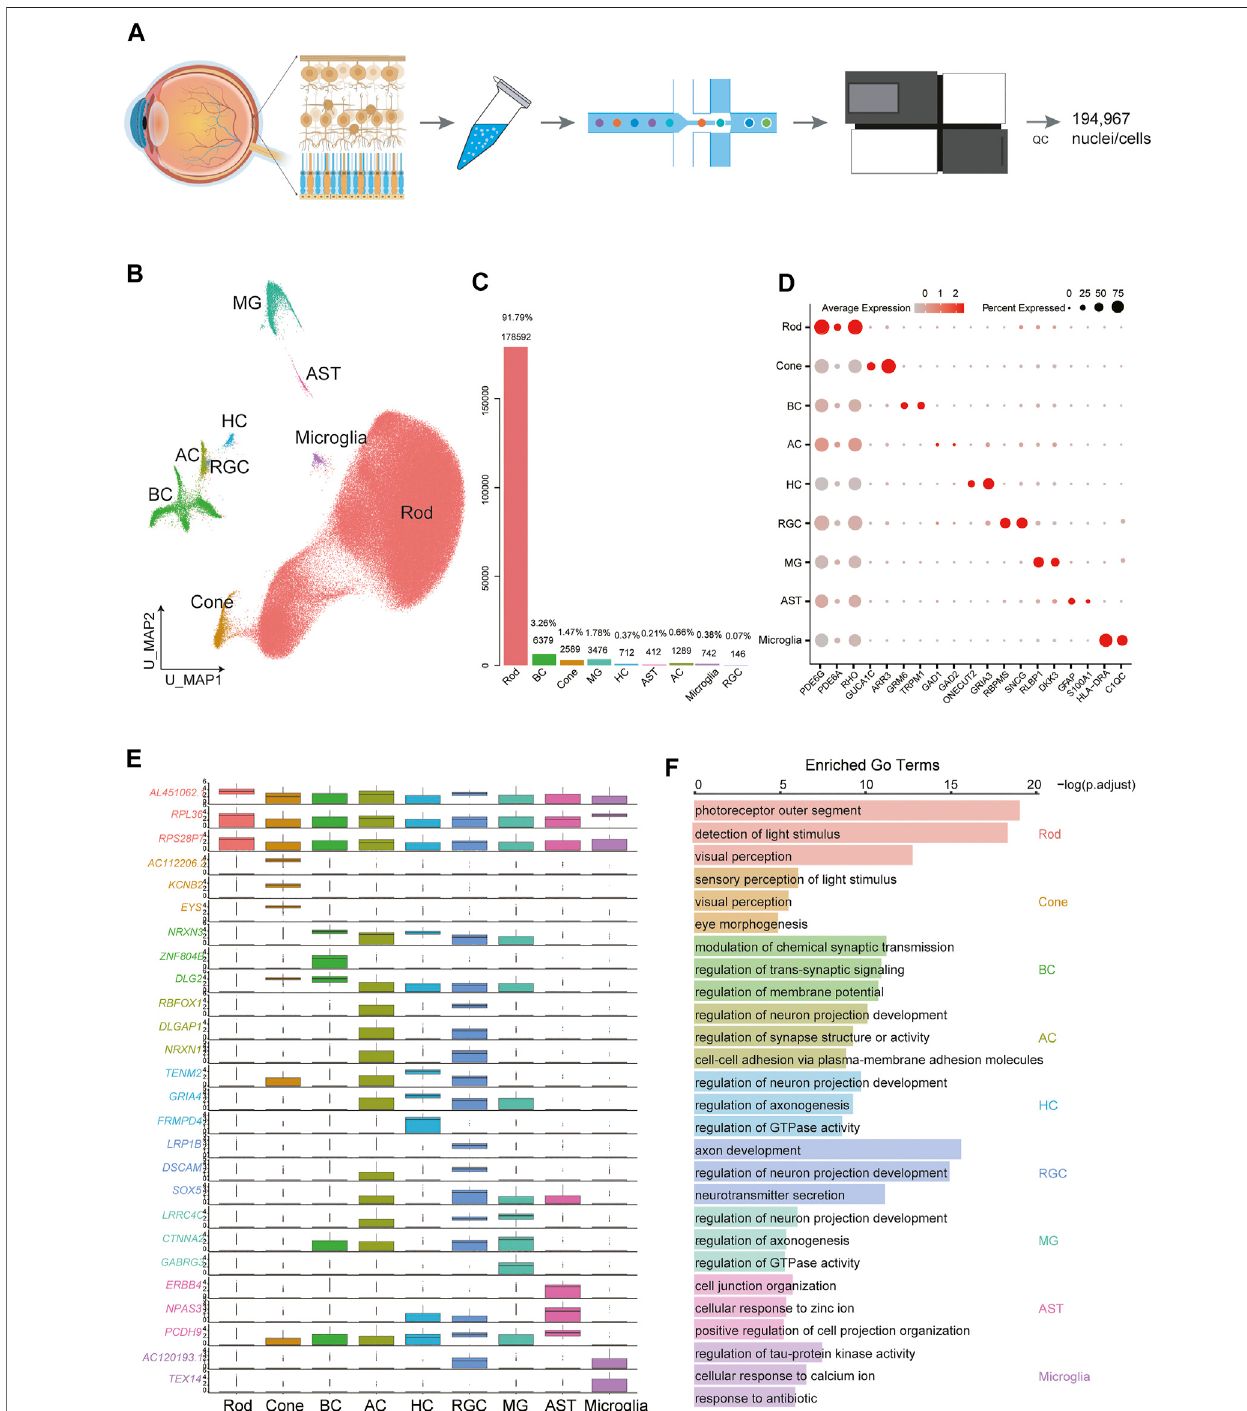
FIGURE1| Cellulardiversityintheretina. (A) Schemeoftheexperimentalandbioinformaticdesignofourstudy. (B) AUMAPmapofalllibraries.Cellsarecoloredby cell-type cluster. (C) Barplot showing the percentage and number of each cell type in the whole dataset. (D) Dot plot for markers of cell types. The size of each dot represents the percentage of cells in each cluster. The gradient from gray to red indicates a gradient from low to high gene expression. (E) Boxplot showing the top differentially expressed gene for each of the 9 cell types. (F) Selected GO terms enriched in each cellular cluster. Bar length denotes the adjusted p value and color denotes the cell